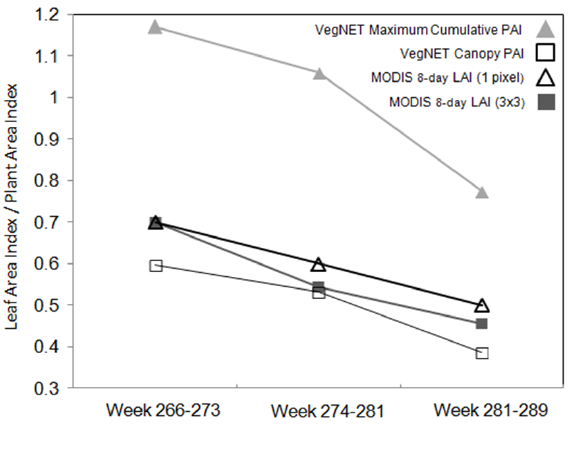
Figure 8. Comparisons of Leaf Area Index values estimated by the MODIS 8-day LAI product vs. Plant Area Index values estimated by the VEGNET IML